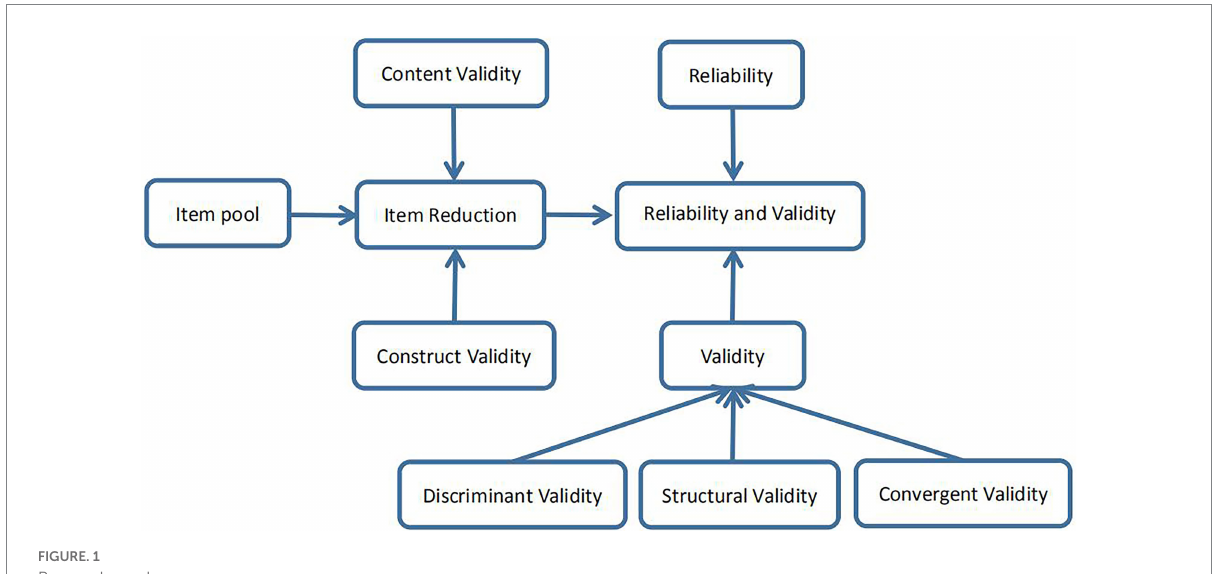
FIGURE. 1 Research